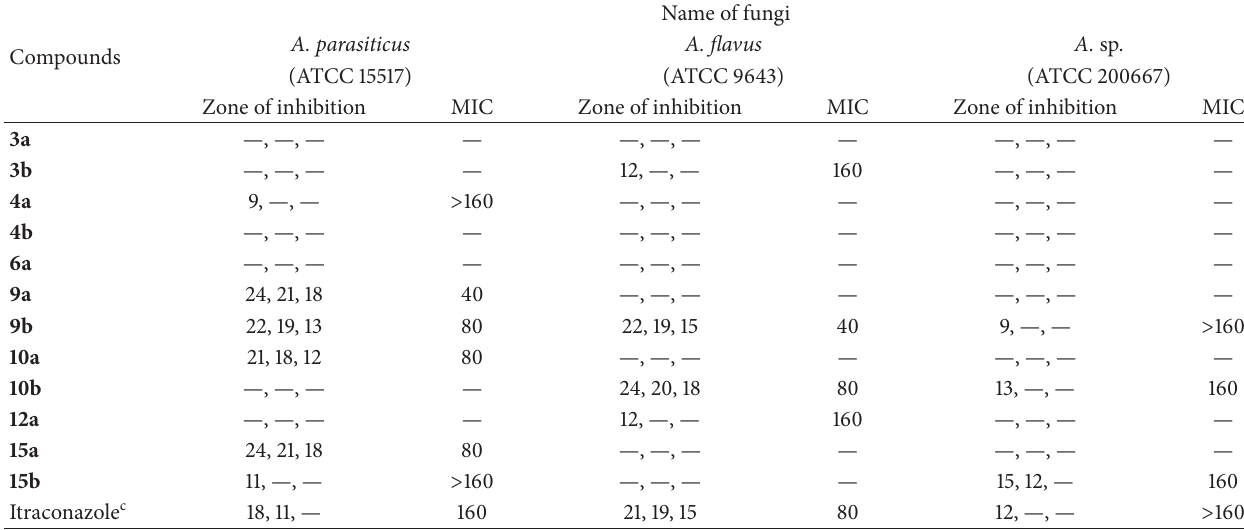
Table 3: Zone a of inhibition and MIC b of sulfonamides against pathogenic fungal